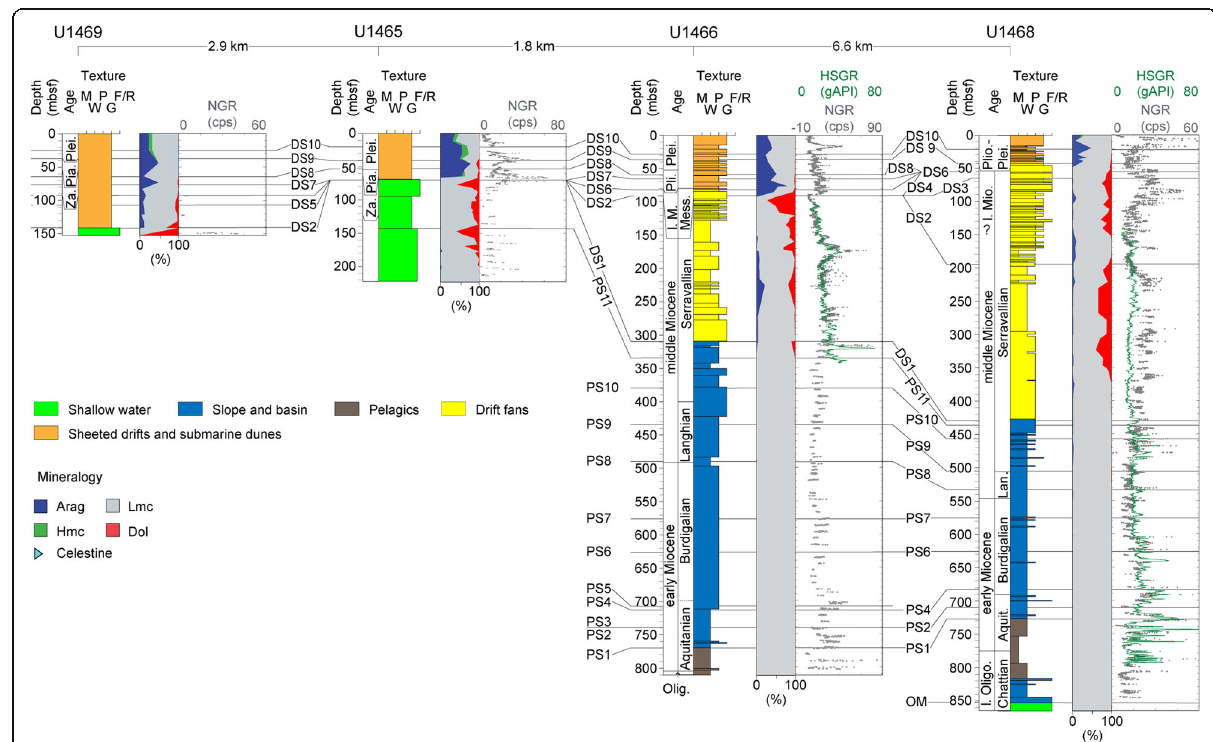
Fig. 4 Sequence stratigraphic correlation of IODP Expedition 359 sites along the northern transect of wells in the Maldives (see Fig. 1 for locations). HSGR: downhole gamma ray log; NGR: gamma ray counts on wholeround cores. See text for details. M mudstone, W wackestone, P packstone, G grainstone, F/R floatstone/rudstone. Carbonate mineralogy: blue : aragonite, green : high Mg calcite, gray : low Mg calcite, red :